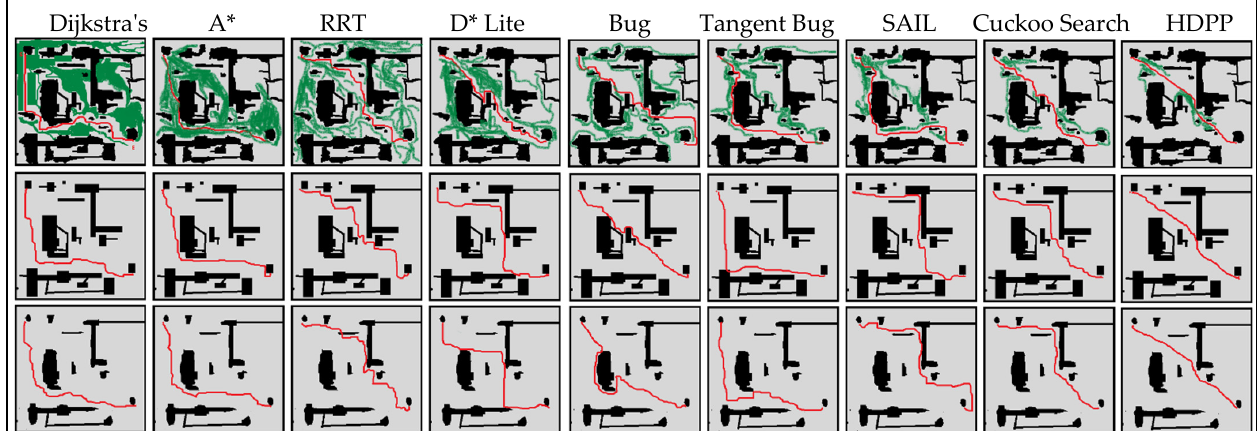
Figure 4. Selected Path Planning Results for Qualitative Experiment. The figures are the planning results of different algorithms on six-degree-of-freedom robotic arm. The three rows are the original scanned map, the normalized map and the simplified map. The black pixels in the figure represent obstacles. The start node (represented by “S”) and the target node (represented by “G”) have been marked in the first column of the first row. The optimal path planned by the algorithm is represented by red nodes, and other explored nodes are displayed in green.